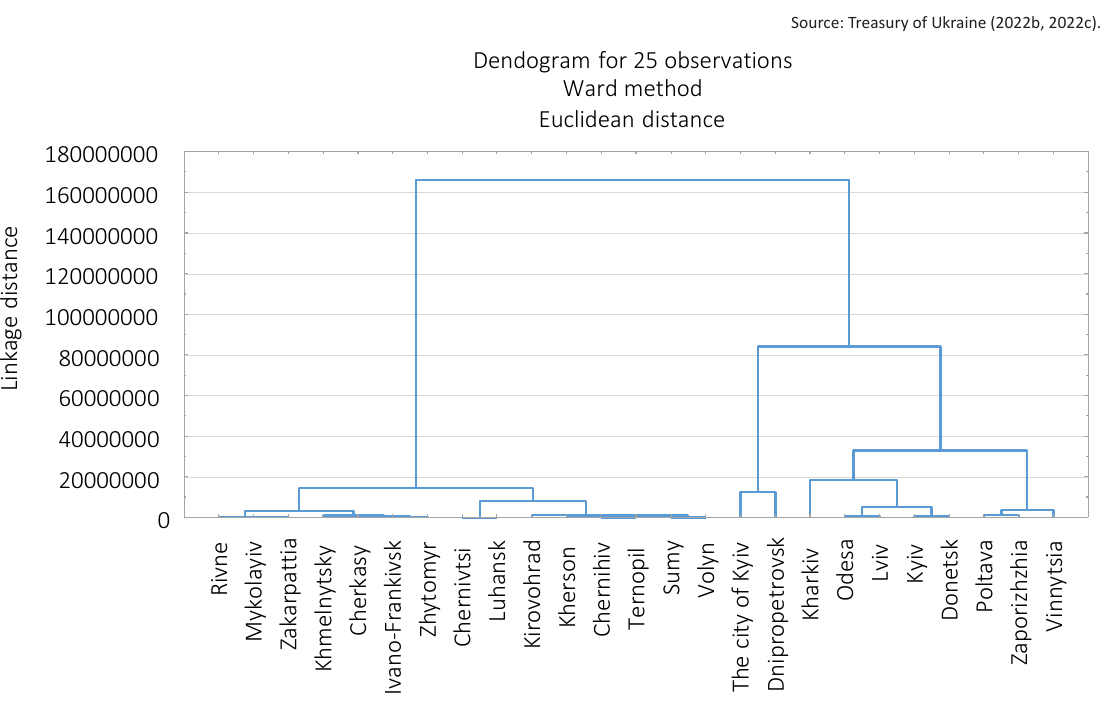
Figure 7. Results of the cluster analysis of administrative-territorial units of Ukraine in